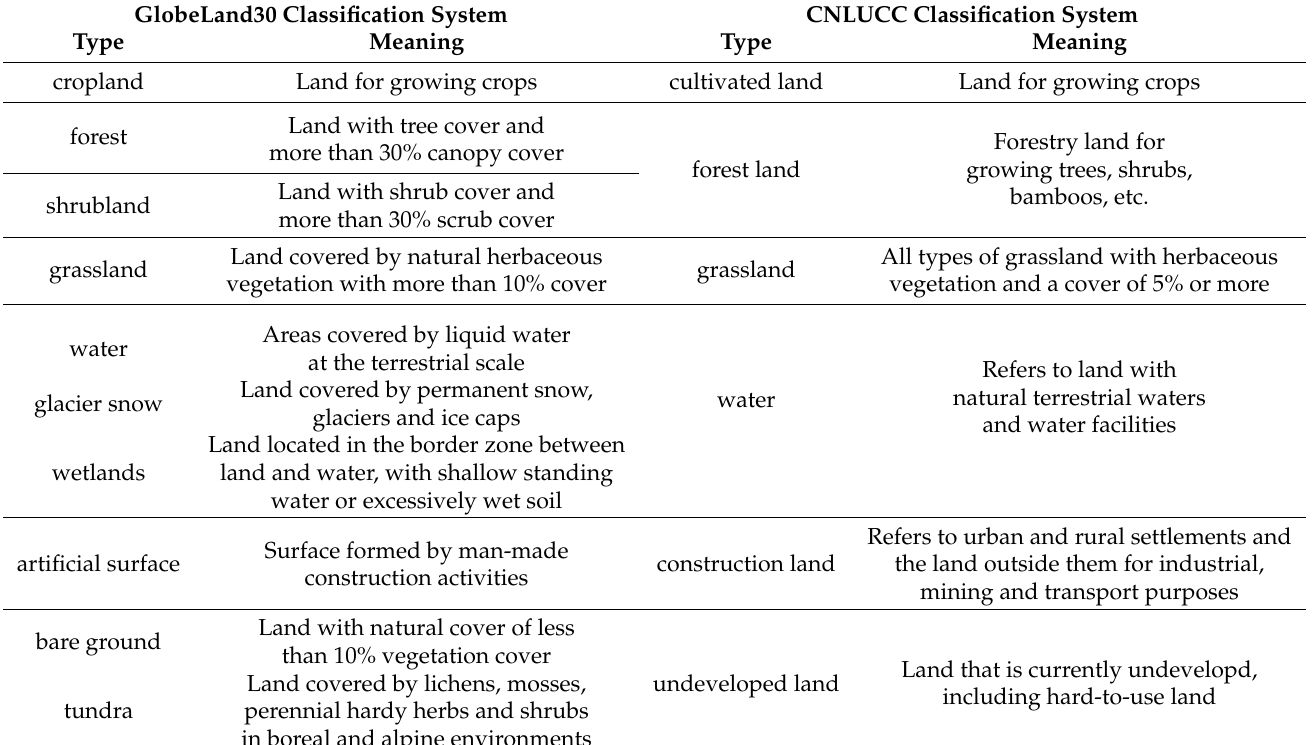
Table 1. The meaning of LULC classification and the method of